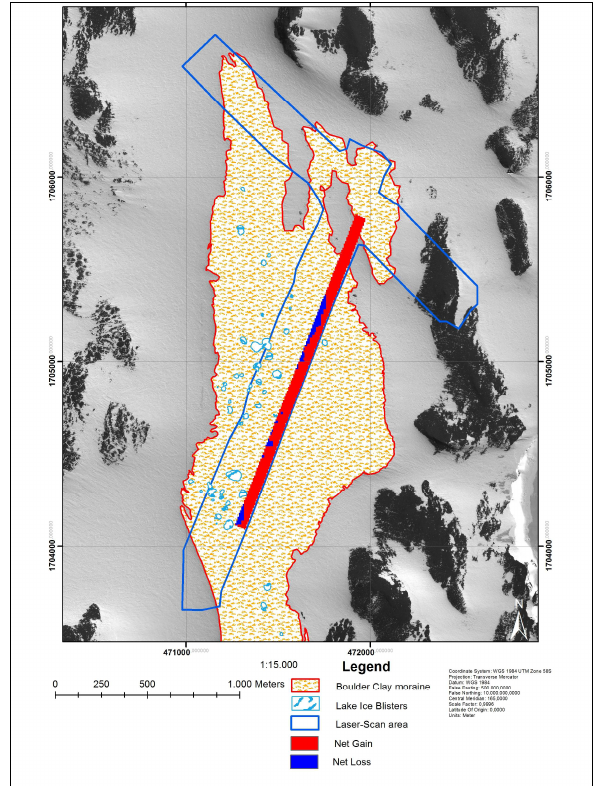
Figure 9. Main runway volume